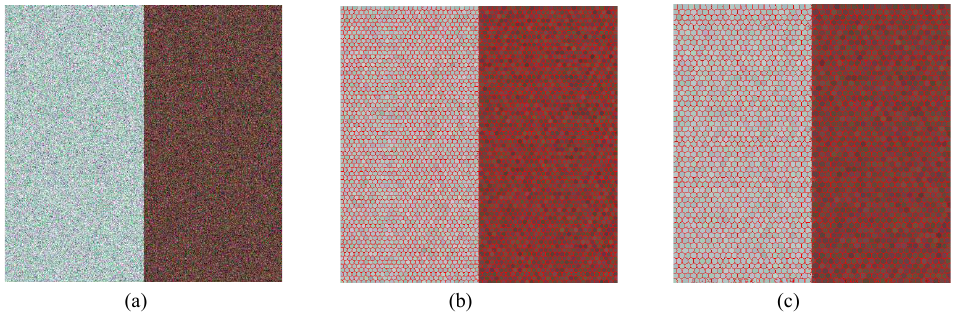
Figure 5. Results of IER based on hexagonal initialization of the 512 × 512 pixel simulated PolSAR image. ( a ) Pauli-RGB image. ( b ) Generated superpixels of N = 64; the RT is 85 s. ( c ) Generated superpixels of N = 100; the RT is 74